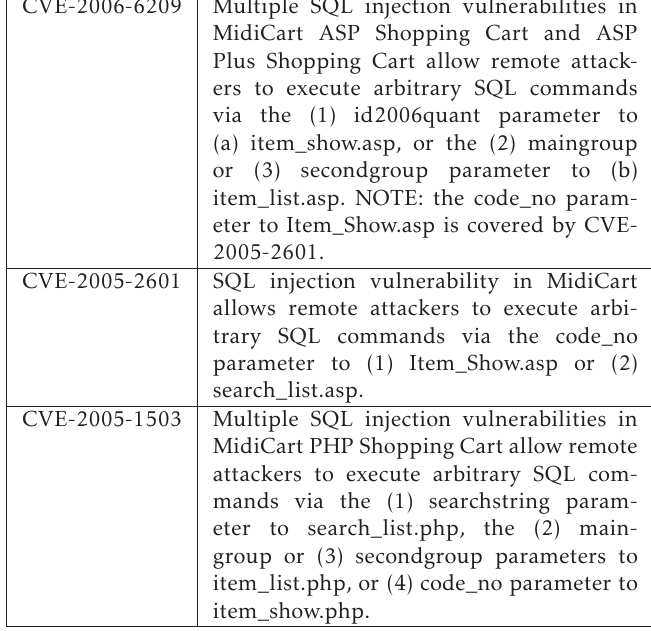
Table 5. Midicart Vulnerability Entries in